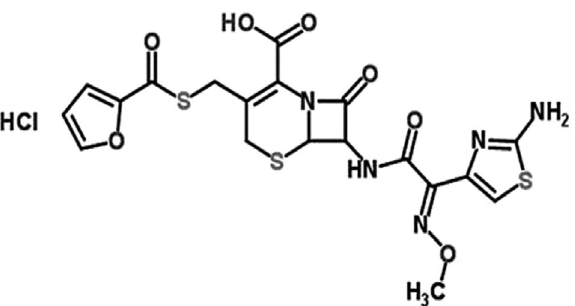
Figure 1. Chemical structure of ceftiofur hydrochloride (modified from Palur et al .2